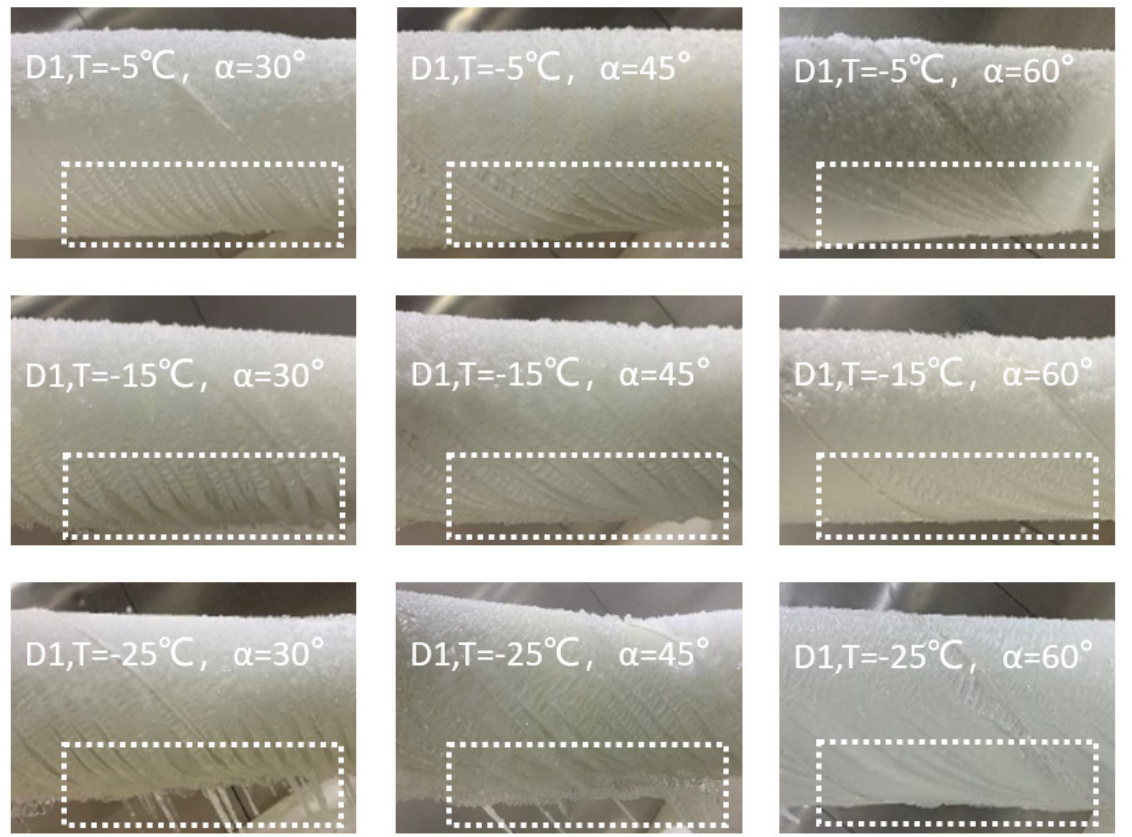
Figure 4. Icing on the side of the cable under di ff erent temperature and inclination angle conditions.